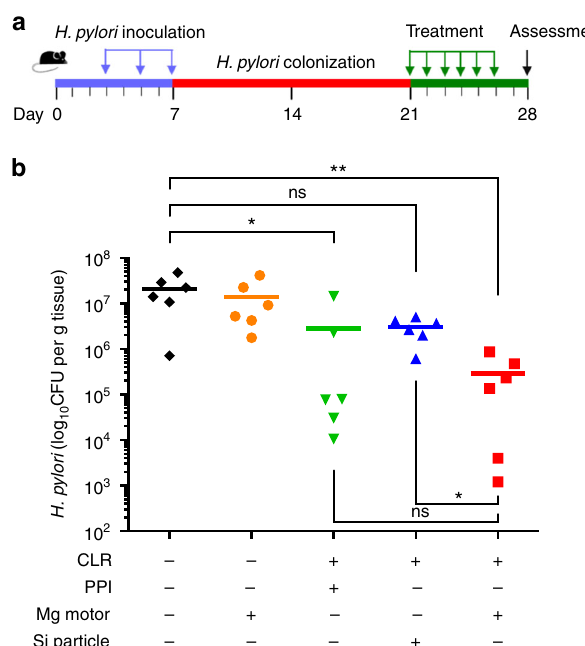
Fig. 4 In vivo anti- H. pylori therapeutic ef fi cacy. a The study protocol including H. pylori inoculation and infection development in C57BL/6 mice, followed by the treatments. b Quanti fi cation of bacterial burden in the stomach of H. pylori -infected mice treated with DI water ( black color ), bare Mg-based micromotors ( orange color ), free CLR+PPI ( green color ), CLR- loaded silica microparticles ( blue color ), and CLR-loaded Mg-based micromotors ( red color ), respectively ( n = 6 per group). Bars